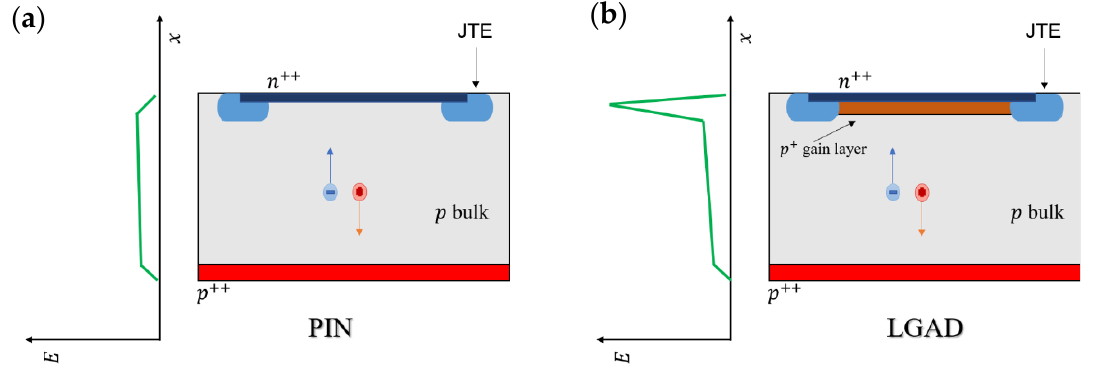
Figure 1. ( a ) a schematic of the cross-section of a pad-like PIN detector and a qualitative profile of the electric field amplitude is shown. ( b ) a schematic of the cross-section of a pad-like LGAD and qualitative profile of the electric field amplitude is shown, there is a peak located in the same region of the gain layer in which the avalanche happens.